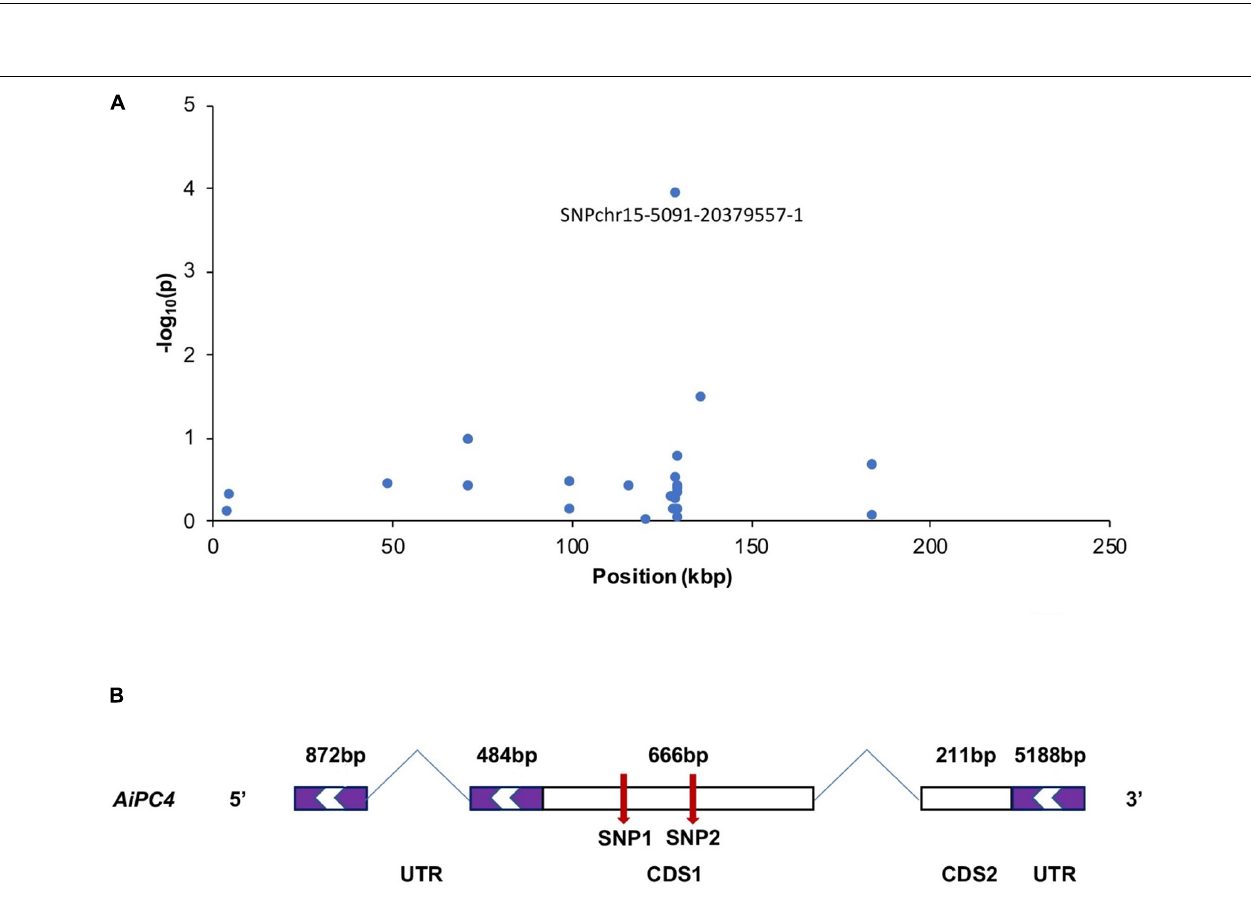
FIGURE 2 | A few neighboring SNP loci on chromosome 15 are independently associated with ABT in bay scallop (A) . The genic structure of AiPC4 (B) . The purple box indicate the 5 (cid:48) UTRs and 3 (cid:48) UTRs (untranslated region); the white boxes represent CDS (coding sequence); and the red arrows indicate the two verified SNPs. The CDS are shown relative to their lengths and the two indicated SNPs are marked in the accurate positions in the genic sequences.